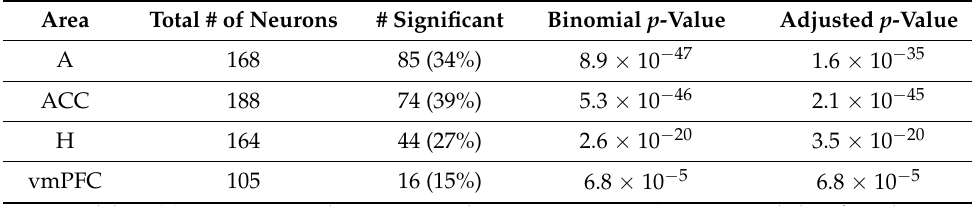
Table 2. Neuronal responses per brain area that differed from background firing.